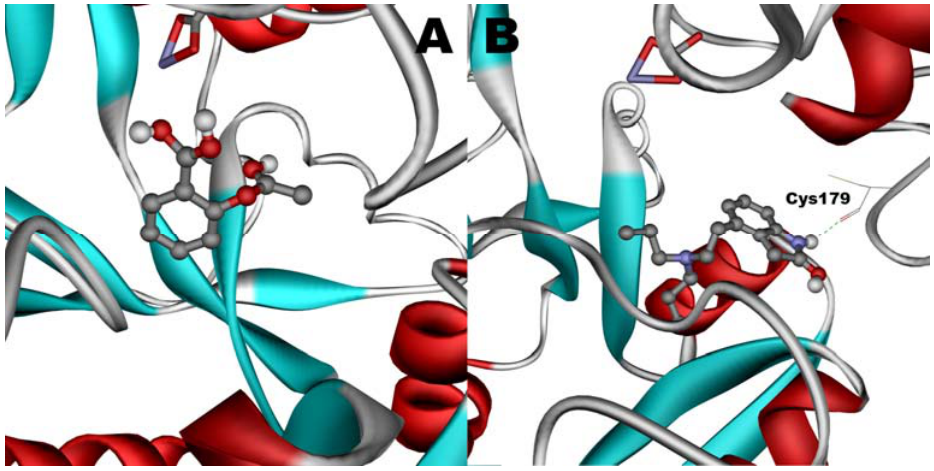
Figure 11. Docking of ASA ( A ) and ROP ( B ) onto hTf. ASA and ROP are shown as balls and sticks. FeCO3, if visible, is shown as sticks. Hydrogen bonds are shown as green dotted lines.